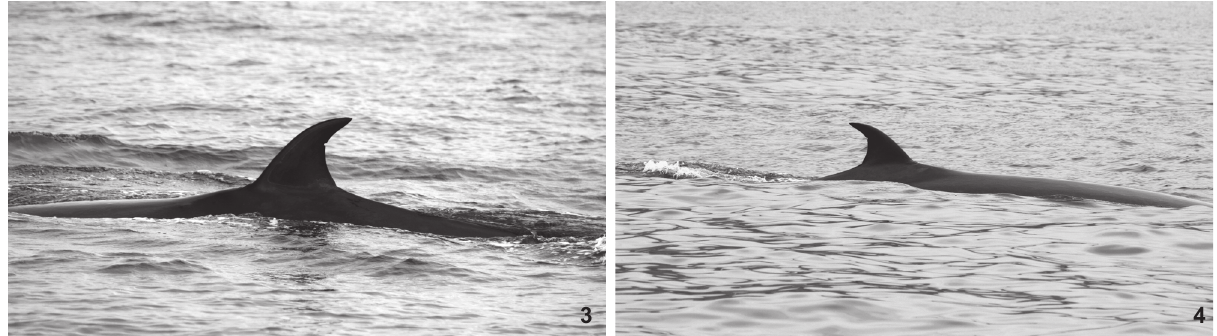
Figures 3-4. Nicks and notches on Bryde’s whale dorsal fin. Pictures are from the same individual (RJB002 – ArCaB004). Copacabana Beach, Rio de Janeiro (3) and Cabo Frio region on February 2014